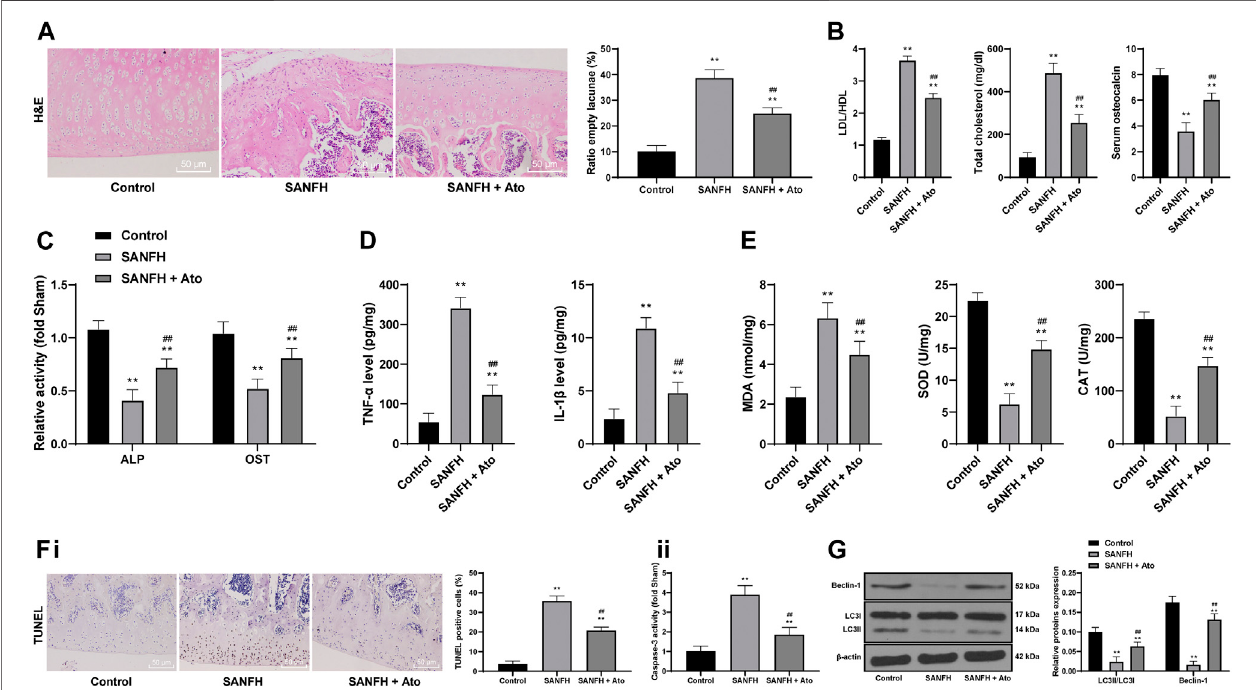
FIGURE 1| Ato relieves SANFH-induced damage and promotes autophagy. (A) HE staining was used toobservethe structure ofthe femoralhead and the rate of empty lacunae; the arrows show empty lacunae; (B) ELISA measured serum TC, LDL/HDL, and OST content; (C) ELISA measured the activity of ALP and OST in the femoralhead; (D) ELISAmeasured TNF- α andIL-1 β levelsinthefemoralhead; (E) ELISAmeasured MDA,SOD,and CATlevelsinthefemoralhead; (F) ,apoptosisofthe femoral head was detected by TUNEL assay (i) and caspase-3 activity test (ii) ; (G) Western blot analysis was used to detect LC3II/LC3I and the expression of Beclin-1toevaluatetheautophagyofratfemoralhead. n (cid:1) 6ineachgroup.Thedataareshowninmean ± standarddeviation.** p < 0.01vs.controlgroup, ## p < 0.01vs. SANFH